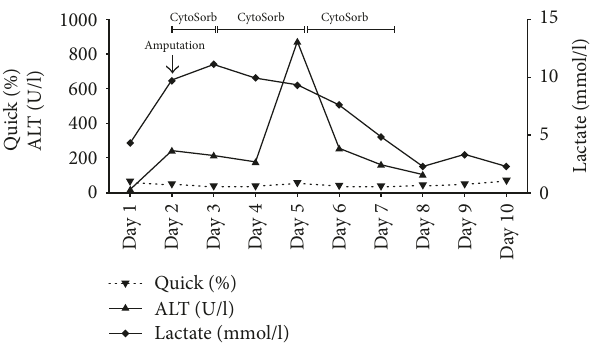
Figure 3: Plasma concentrations of Quick, ALT, and Lactate during the course of the three Cytosorb sessions. Day 1 represents start of treatment after postoperative transfer to the ICU (ALT: alanine